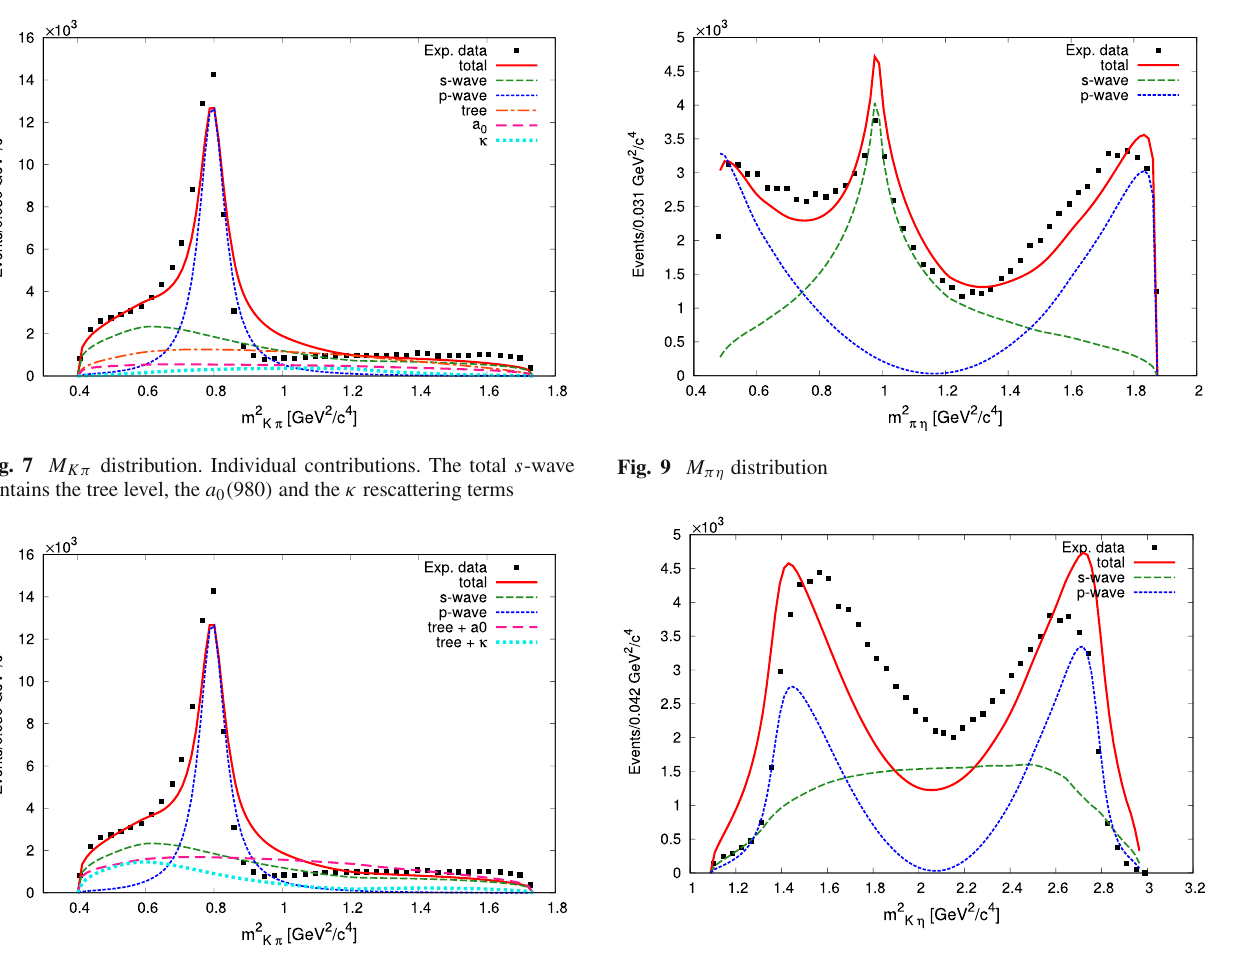
Fig. 8 M K π distribution. Combined contributions. The total s -wave contains the tree level plus the a 0 ( 980 ) and the κ rescattering terms √ replacing 2 K − ηπ + / 3 in Eq. (7). There is a 15% differ-